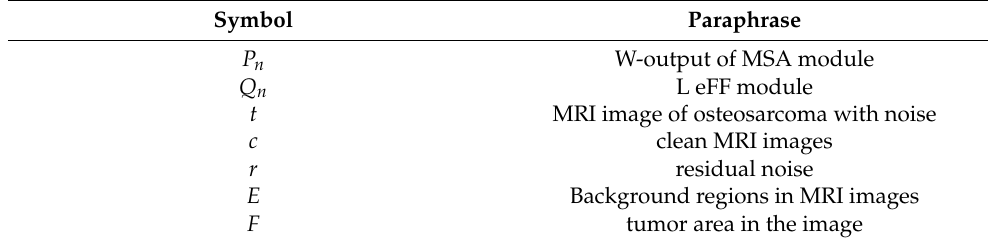
Table 1. Some symbols and their meanings.